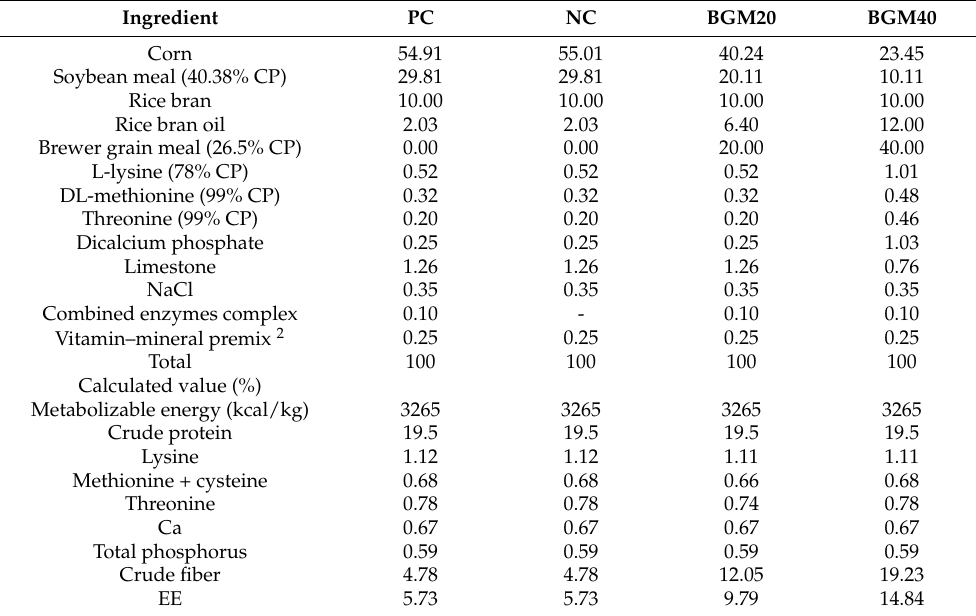
Table 1. Ingredients and composition values of the experimental diets (% as-fed basis) 1